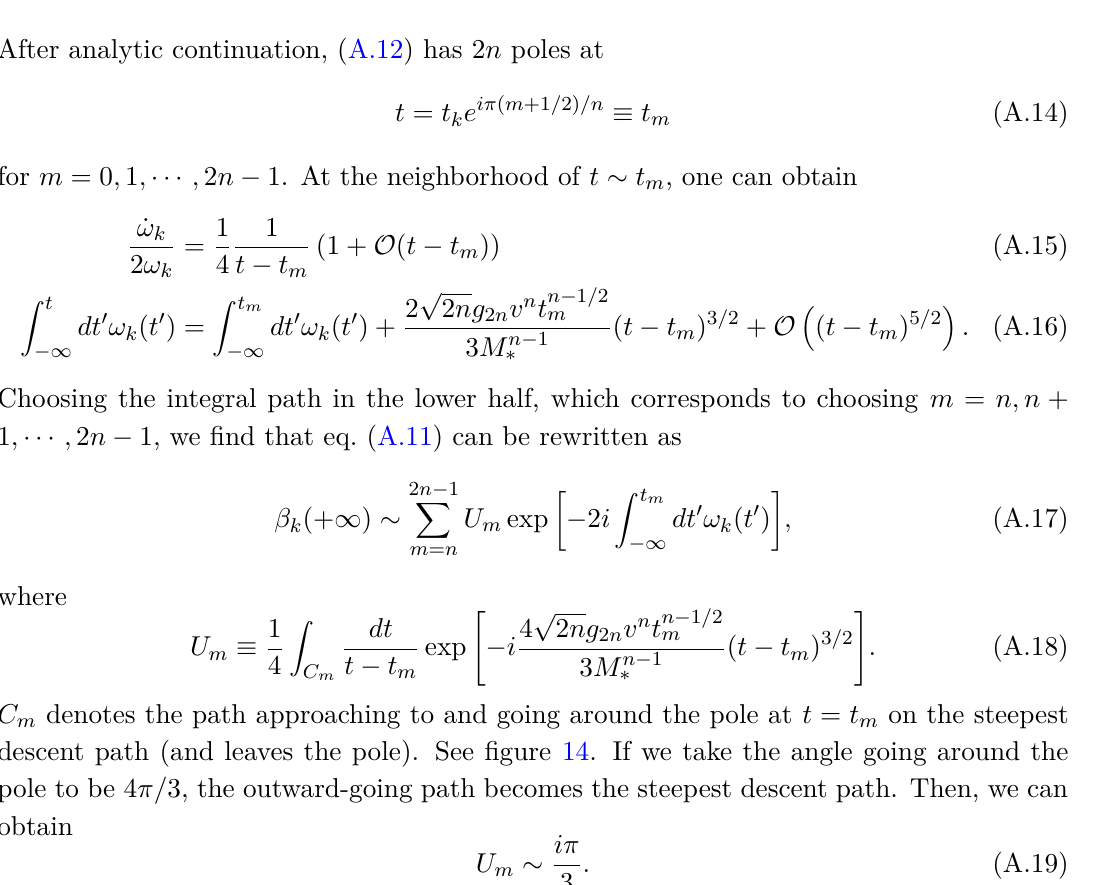
Figure 14 . The path of integration on the t complex plane. (This figure is the same as the one used in ref. [12].) The dots show the poles which are also saddle points, and the wavy lines show the branch